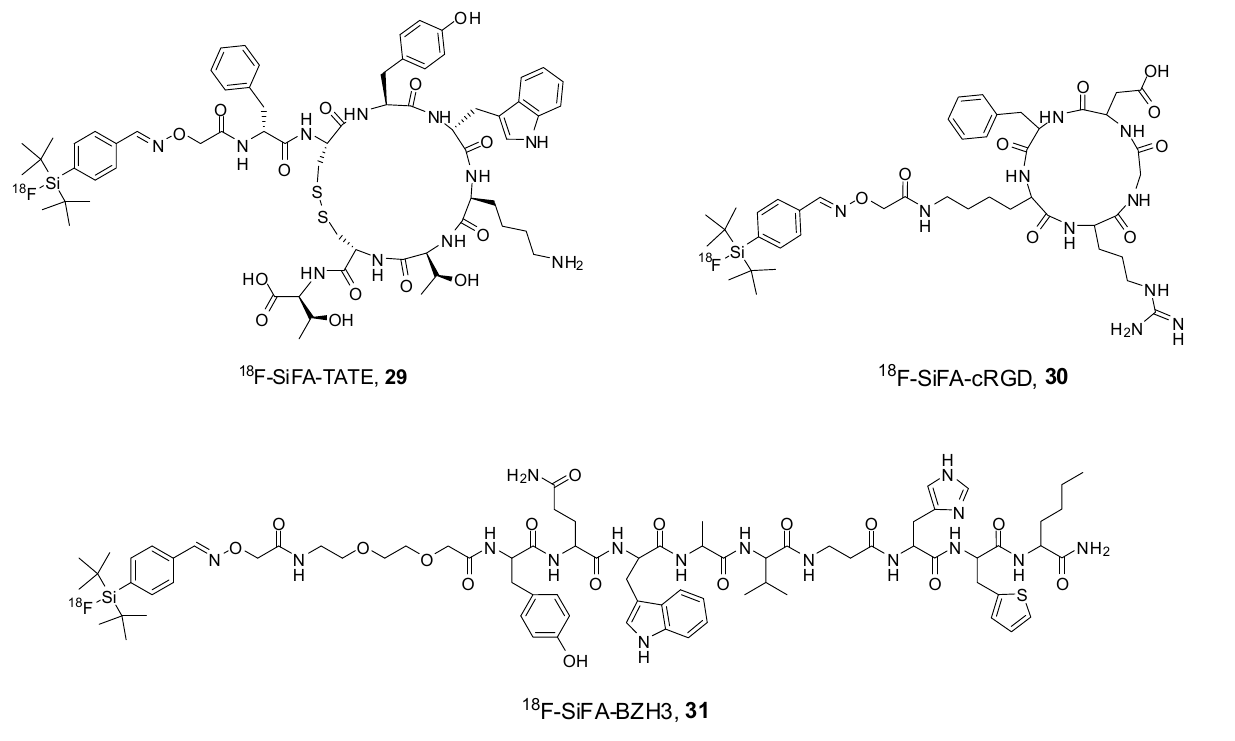
Figure 9. Structures of 18 F-SiFA-TATE ( 29 ), 18 F-SiFA-cRGD ( 30 ) and 18 F-SiFA-BZH3 ( 31